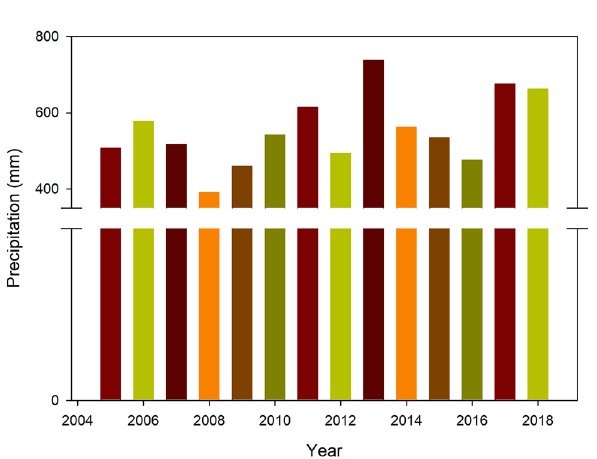
Figure 2. Precipitation in the study area.